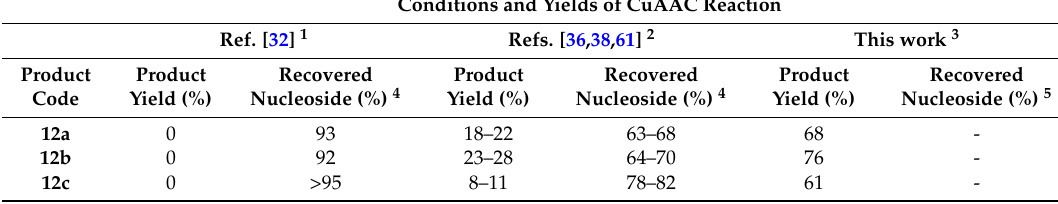
Optimization of CuAAC conjugation reaction of 3 (cid:48) - O -acetyl-5 (cid:48) -azido-2 (cid:48) ,5 (cid:48) -dideoxy- nucleosides and 3- O -propargyl-13 α